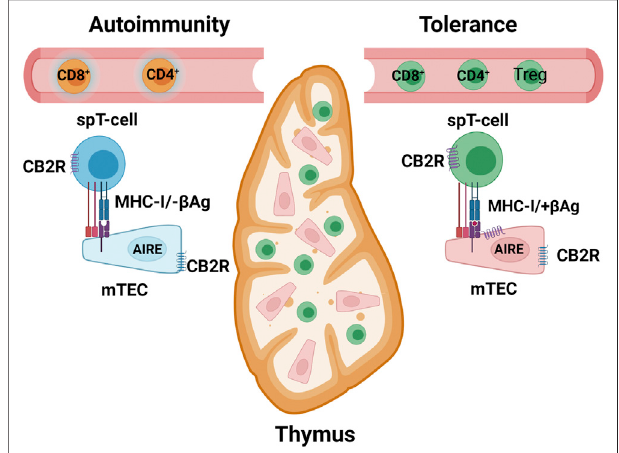
FIGURE 4 | MHC-I β -cell restricted antigen (+ β Ag) or no antigen ( − β Ag) presentation in medullary epithelium cells (mTEC) inside thymus. AIRE, autoimmune regulator for ectopic expression of β -cell-speci fi c genes. spT cells, single-positive CD8 + or CD4 + T cells. Yellow represents self- reactive and green self-tolerance T cells. Purple serpentine represents CB1R in β -cells and blue serpentine CB2R in immune